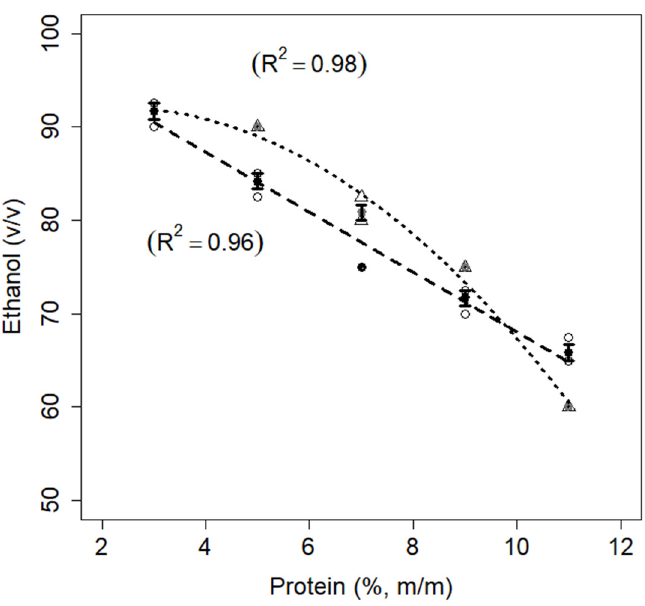
Figure 5. Relationship between ethanol stability and protein concentrations for skimmed milk (dashed line) and mixed protein (dotted line) samples. The figure shows the data points for milk (circles) and mixed samples (triangles), error bars (SE), fitted curves, and adjusted coefficients of determination (R 2 ).